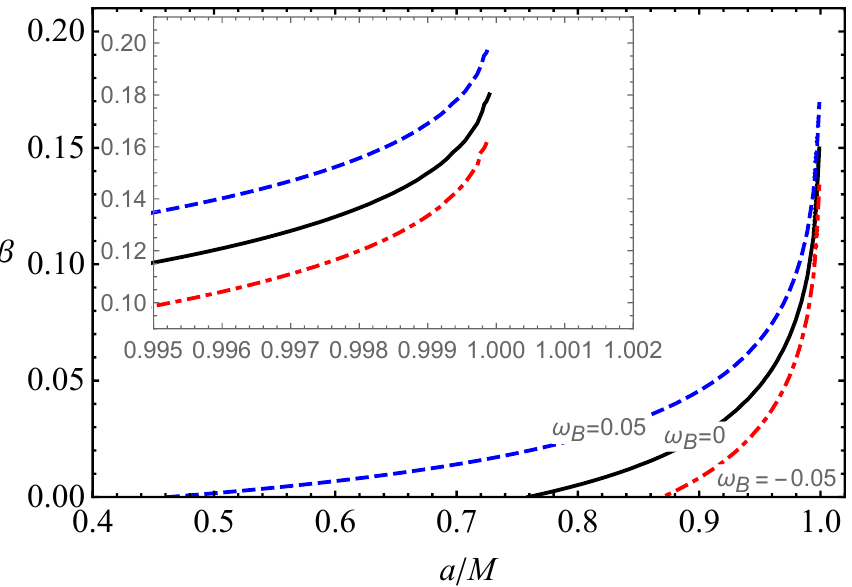
Figure 7. Degeneracy between the parameter β and the spin parameter of Kerr BH, providing the same energy efficiency for different values of parameter ω